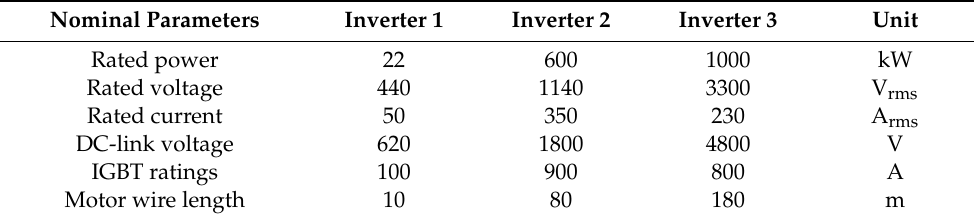
Table 4. Experiment setup data for three-level NPC inverters used in experiments.